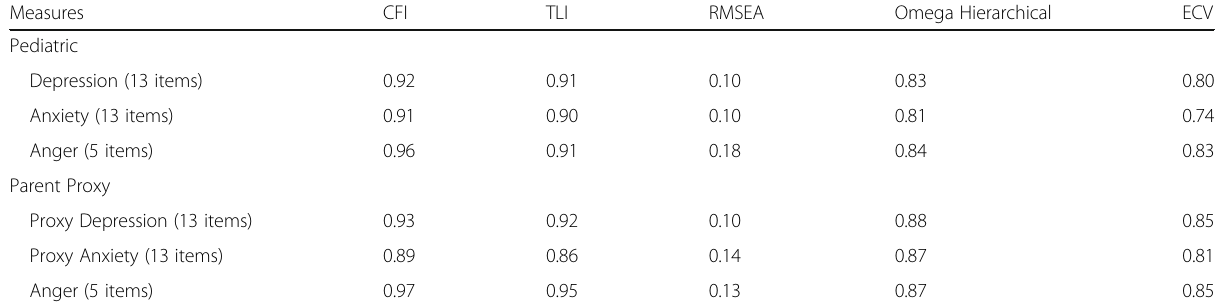
Table 3 Model fit indices for Depression, Anxiety, and Anger